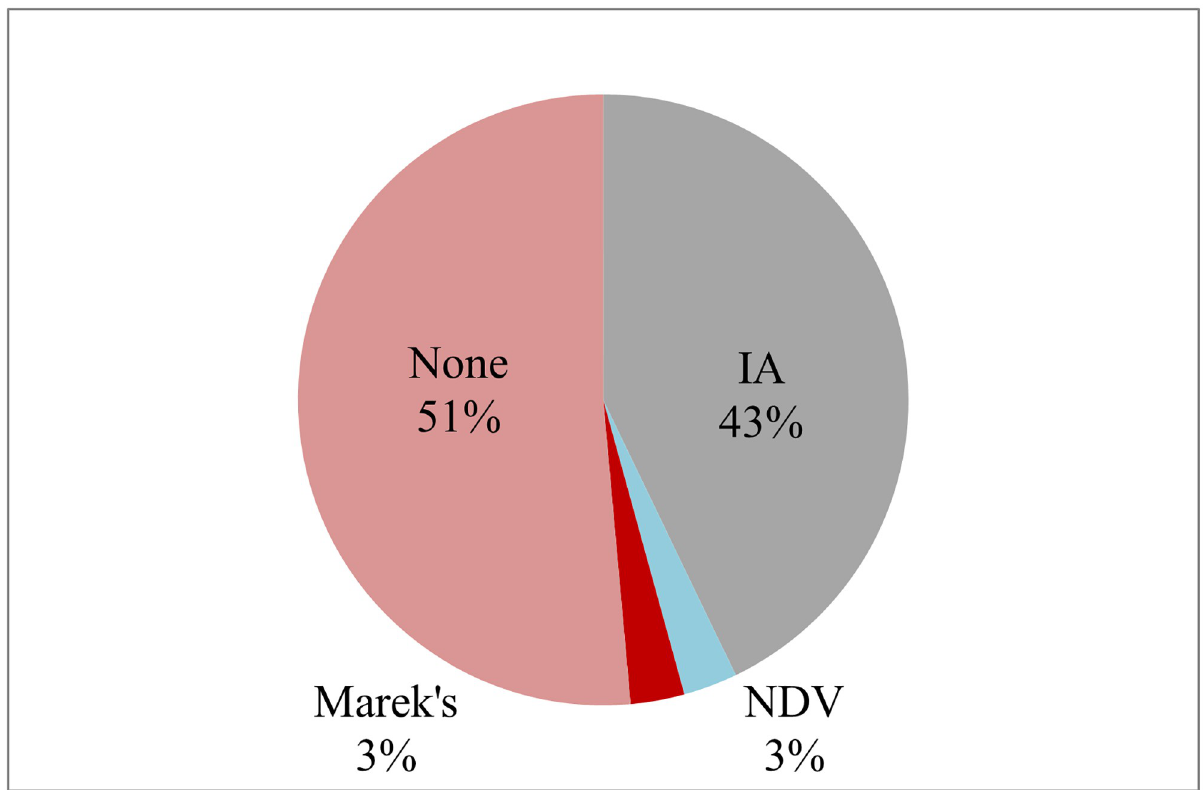
Fig 5. Commercial poultry farmers’ perception to diseases that were responsible for outbreaks in their poultry farms. Majority (43%) thought Bird flu was responsible for disease outbreaks, only few (3%) blamed ND for making their birds sick.